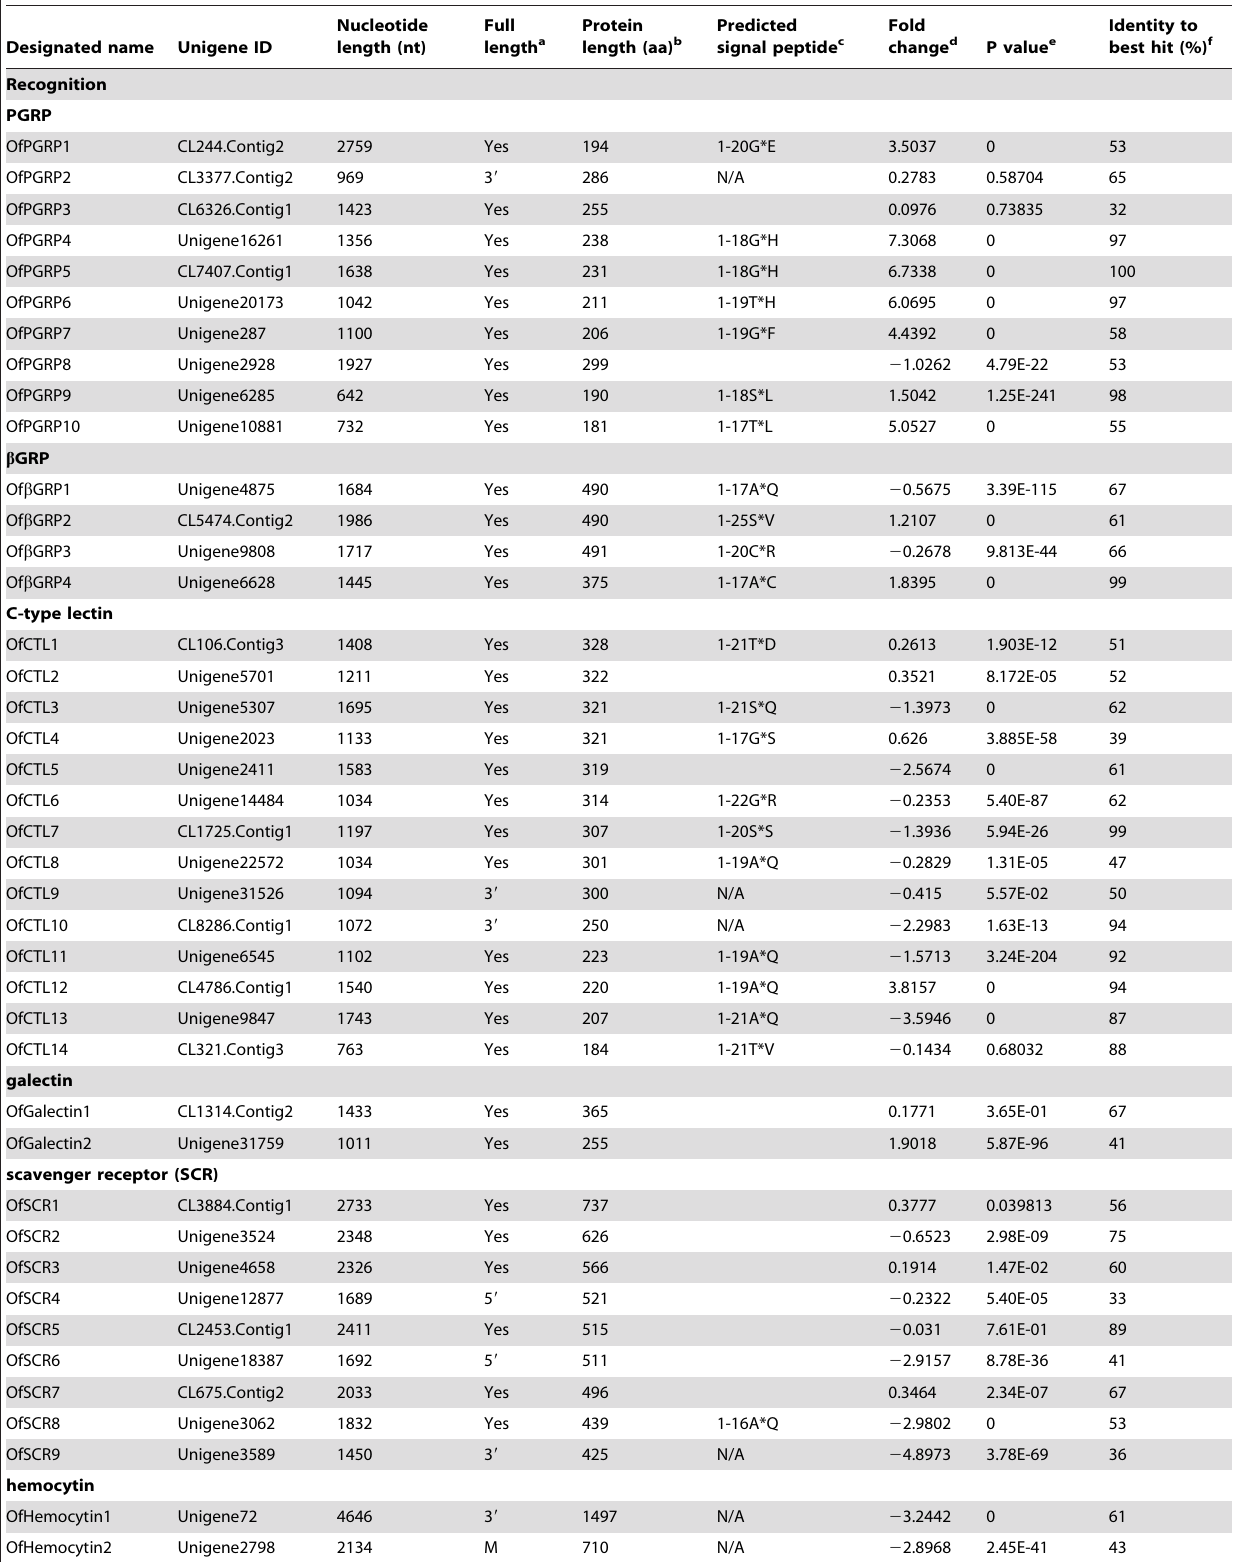
Table 2. Summary of the putative immunity-related unigenes identified in O. furnacalis